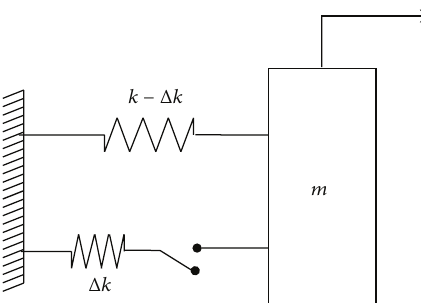
Figure 1: Single degree-of-freedom system with on-off switchable